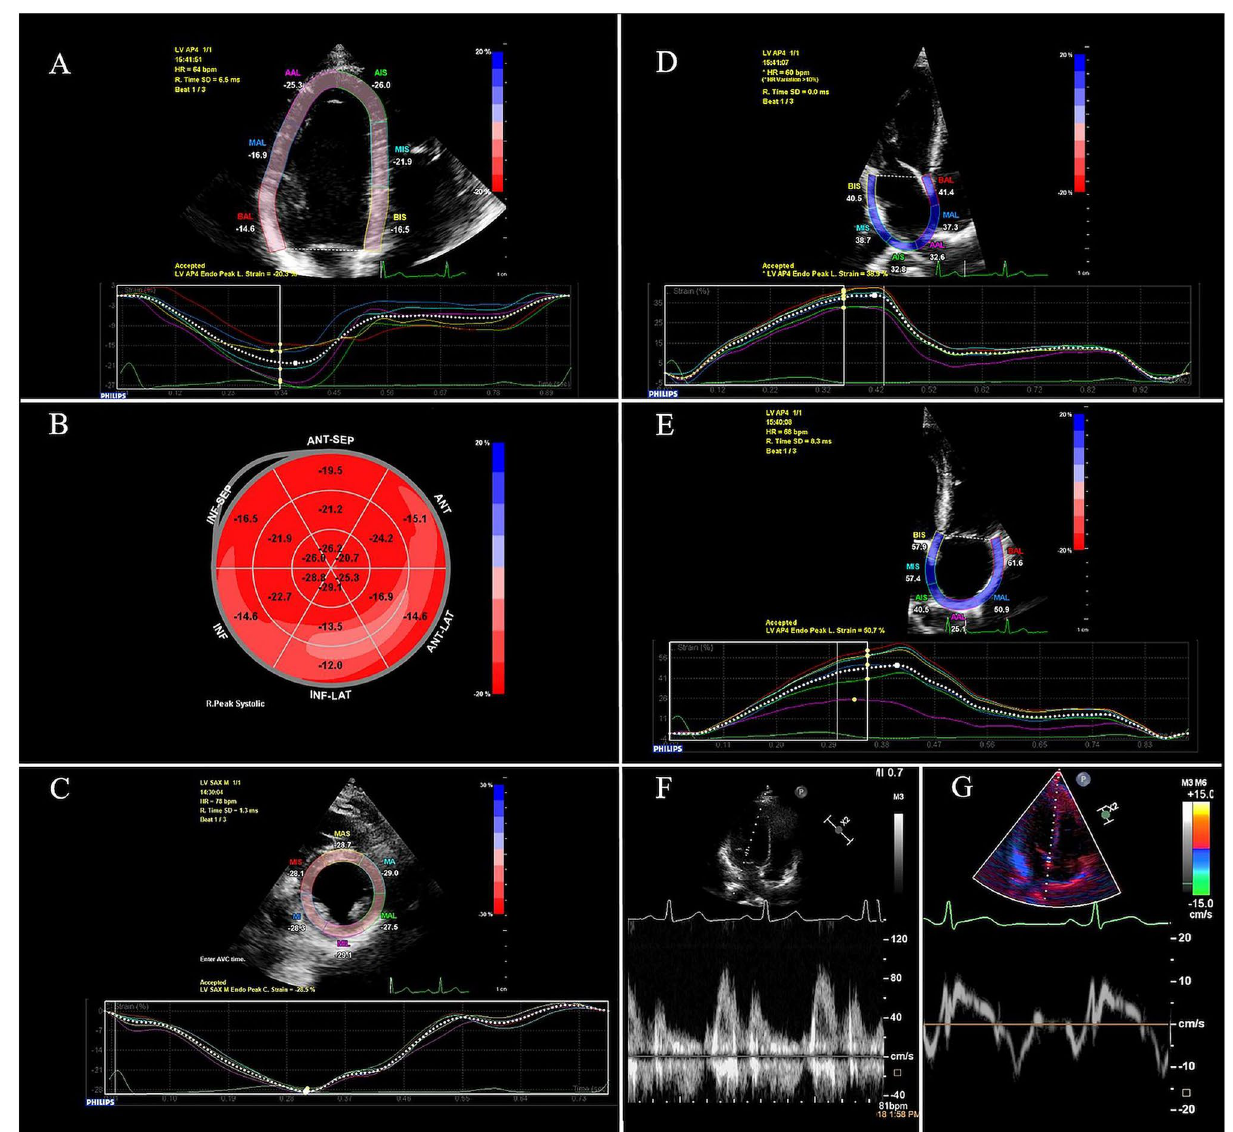
Figure 1. 28-year-old male patient, with a 15-year history of T1DM. His HbA1c was 6.5% at inclusion. No signs of hypertensive heart disease. ( A ) Apical four-chamber view depicting the region of interest and the segmental longitudinal strain curves created by the speckle-tracking software. ( B ) Bull’s eye demonstrating the segmental peak systolic longitudinal strain values in the entire LV. Value of GLS is − 20.4%. ( C ) LV parasternal short-axis view at mid-papillary level depicting the region of interest and the segmental circumferential strain curves created by the software. Value of GCS is − 28.5%. ( D ) LA-focused apical four-chamber view depicting the region of interest and the LA strain curve created by the speckle-tracking software. LA reservoir strain: 38.9% ( E ) RA-focused apical four-chamber view depicting the region of interest and the RA strain curve created by the speckle-tracking software. RA reservoir strain: 50.7%. ( F ) Spectral Doppler curve of the mitral inflow. Mitral E: 81 cm/s, Mitral A: 62 cm/s. ( G ) Pulsed tissue Doppler curve measured on the septal border of the mitral annulus. Mitral e ′ : 11.3